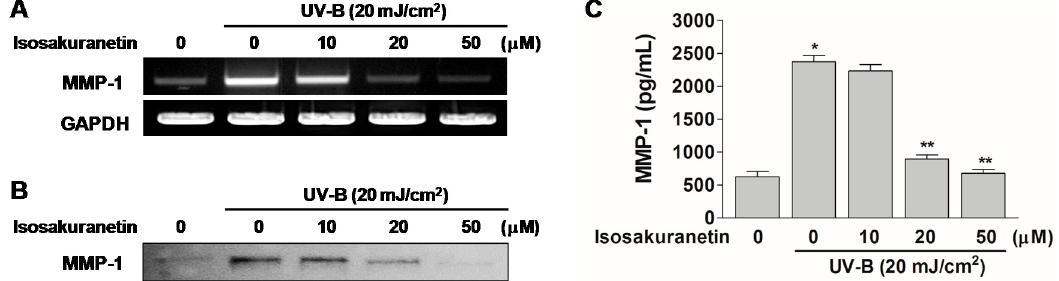
Figure 4. Effect of isosakuranetin on MMP-1 expression in UV-B-irradiated HaCaT cells. HaCaT cells were pretreated with various concentration of isosakuranetin for 24 h and then irradiated with UV-B (20 mJ/cm 2 ) for 15 s. UV-irradiated cells were then cultured for another 24 h. Levels of MMP-1 mRNA were evaluated by RT-PCR. GAPDH mRNA was used as internal control ( A ); Levels of MMP-1 proteins were measured by Western blot analysis using a monoclonal antibody against human MMP-1 ( B ) and quantified by enzyme-linked immunosorbent assay (ELISA) ( C ). All data are given as means ± SD of at least three independent experiments with triplicate samples. * p < 0.05 vs. negative control, ** p < 0.05 vs. positive control.